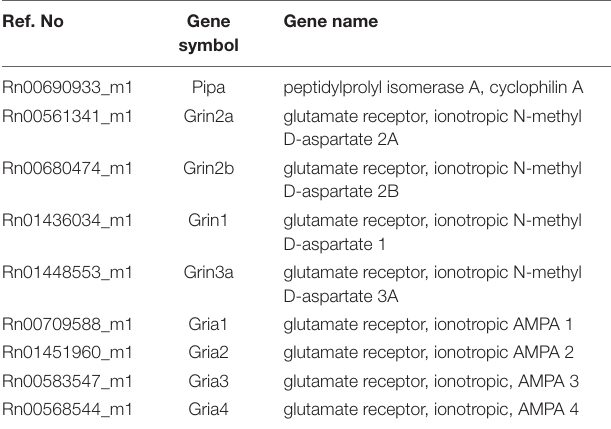
TABLE 1 | The list of TaqMan probes used in the